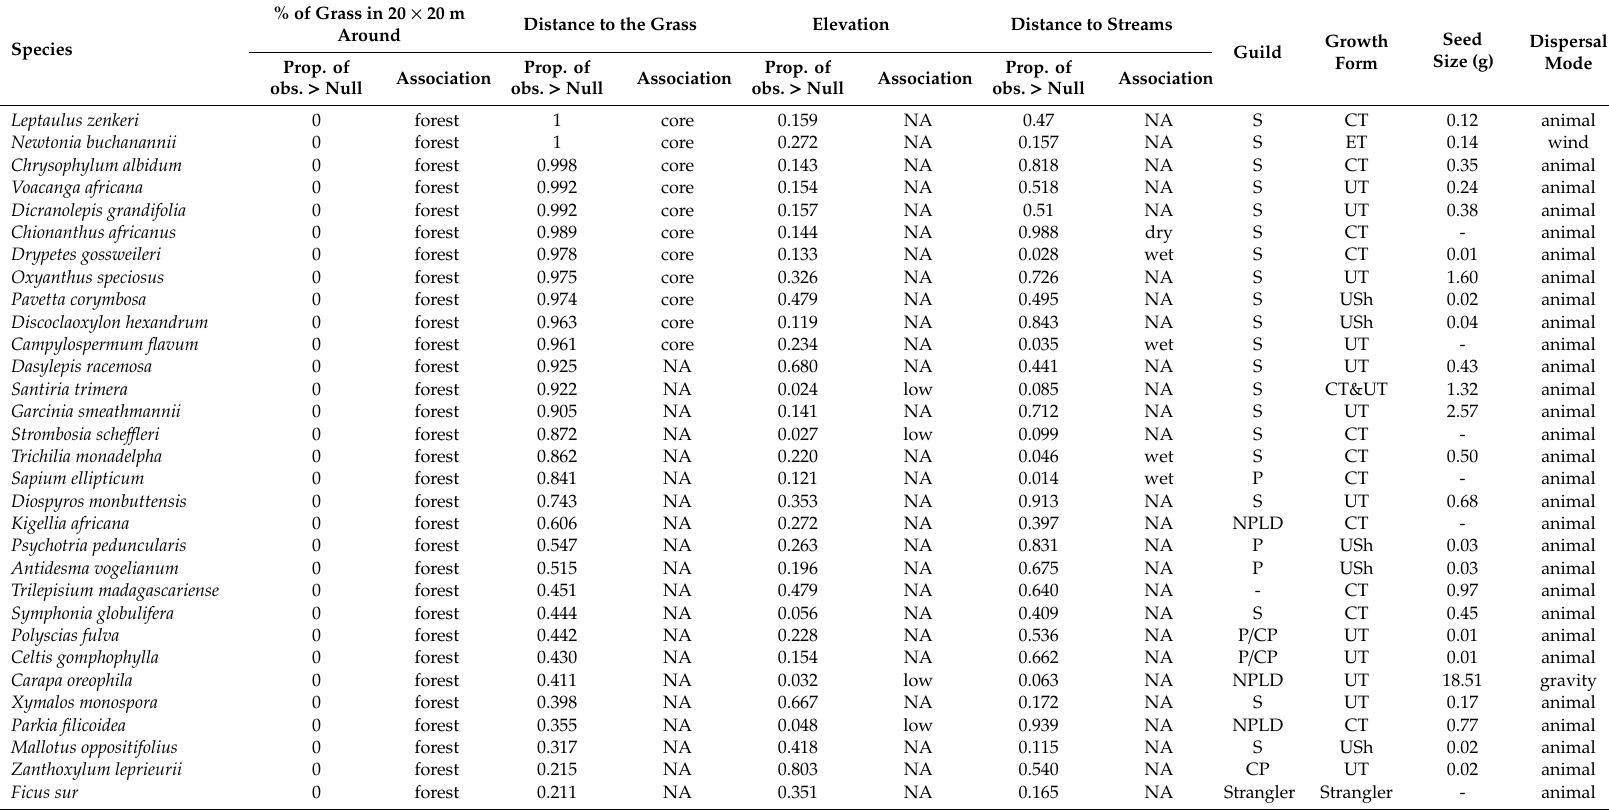
Table 3. Associations between the distribution of the common species and four environmental gradients in the Ngel Nyaki plot (Nigeria). The numeric values correspond to the proportion of null values (medians across individuals, except in the case of % of surrounding grass, which are means) that are lower than the observed value. The columns “association” contain a short label for the ecological interpretation of the results: forest vs. savannah species, edge vs. core species (core = species that are significantly far from the grass), species that prefer low vs. high elevations, and species that prefer being close to the streams (wet) or far from them (dry). NA’s mean that a given association does not deviate significantly from the expected by the null model. We include species guild, growth form, seed size, and dispersal mode (Growth-form categories of species were ET = emergent tree, CT = canopy tree, UT = understory tree, USh = understory shrub, ST = savannah tree, Sh = shrub (modified from [27]). Species shade tolerance guilds included P = pioneer, S = shade-tolerant, CP = Cryptic pioneer, NPLD = Non-pioneer light demanding, G = Grassland (modified from [35]). Dashes (-) signify insu ffi cient